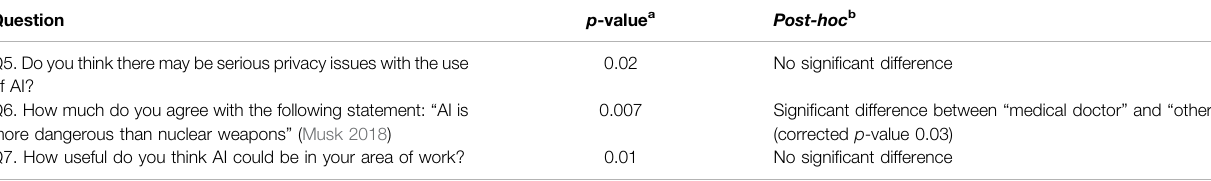
TABLE 4 | Post-hoc analysis for questions Q5-7 according to participants ’ profession. Question